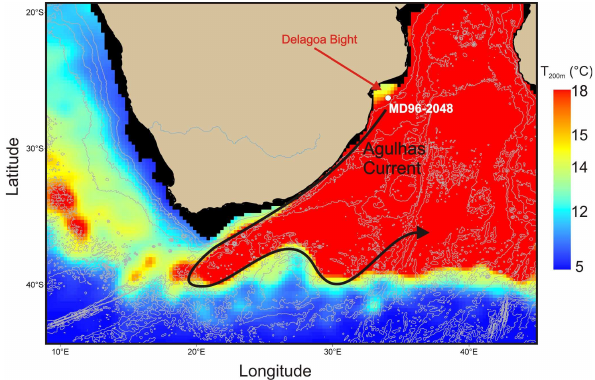
Fig. 4. Ocean temperature at 200m depth in the Agulhas cur- rent region (long-term annual means (years 1900–1992) from NODC WOA94 data provided by the NOAA/OAR/ESRL PSD, Boulder, Colorado, USA, from their web site (http://www.esrl.noaa. gov/psd/; the bathymetry is also indicated with a 1000m step: http://www.gebco.net/). The colour histogram was equalized to re- inforce the vision of the temperature values which are close and give more contrast to the area where gradients in temperature are strong. Low temperature values are clearly observed in the Delagoa Bight and are probably indicative of the trapped lee eddy (Lutjeharms and da Silva, 1988). However, our core site seems preserved from the effect of this eddy and from upwelled waters flowing Fig. 3. Comparison of SST records from core MD96-2048 and BIT 0 index. (A) U K (green line), TEX H (orange line), Mg/Ca (blue 37 86 line), and the SST stack (red line). (B) Comparison of the SST stack (red line) with PC1. (C) BIT index values (purple line). T indicates terminations and numbers indicate marine isotopic stages (MIS).